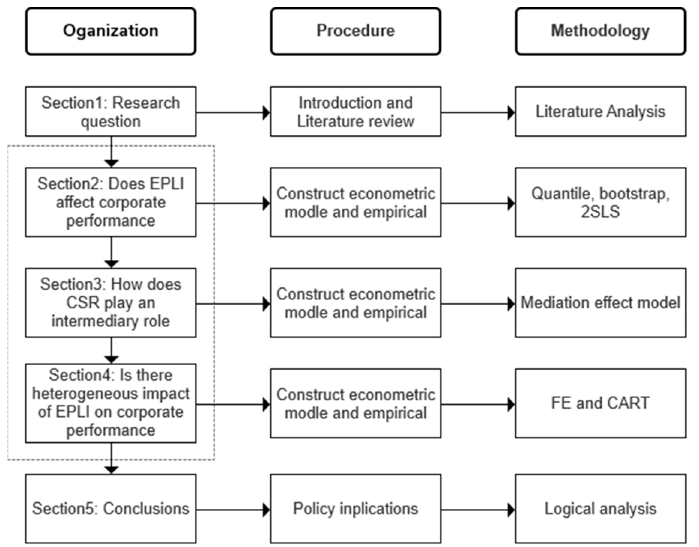
Figure 1. The logical framework of this paper.